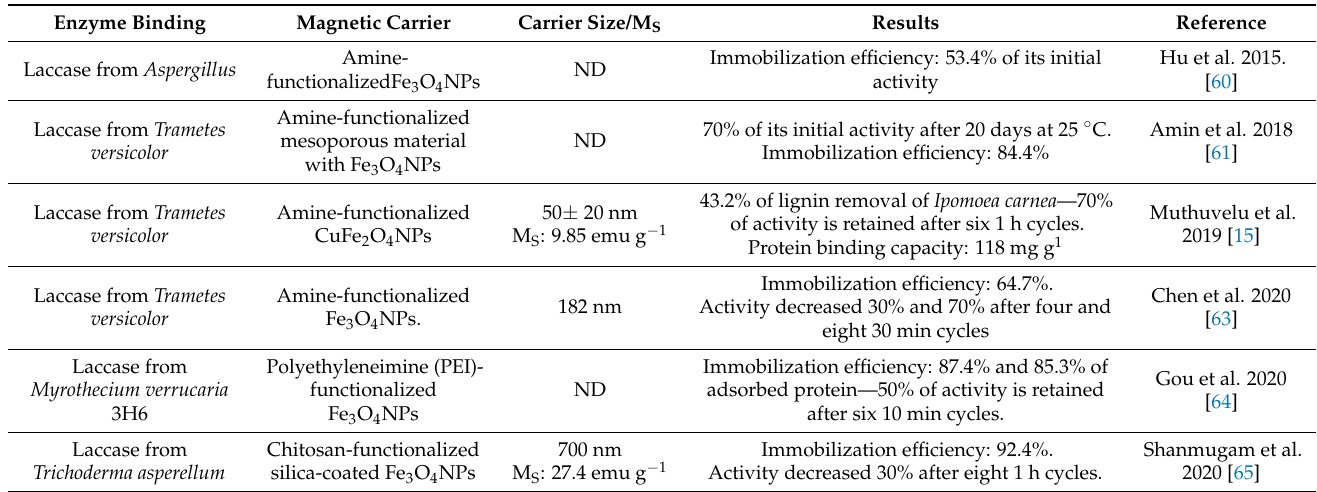
Table 4. Selected procedures of magnetic conversions using lignin-degrading